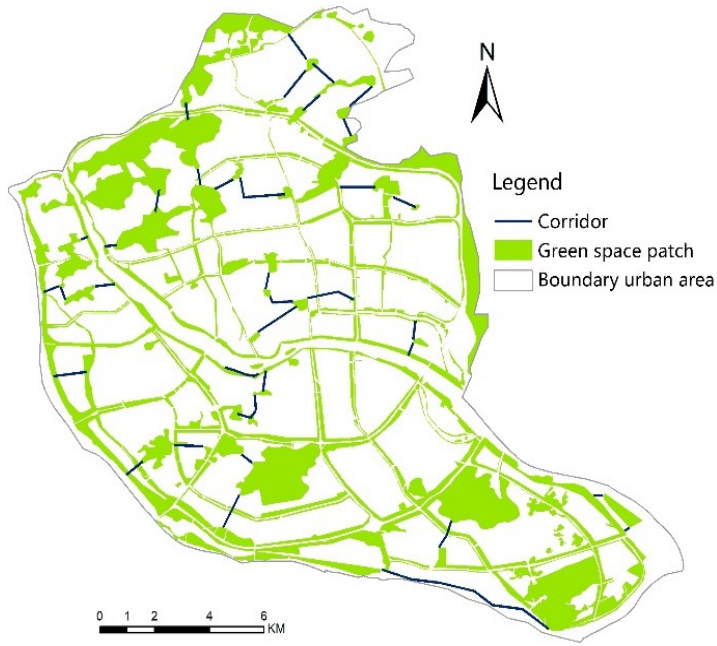
Figure 12. Network planning of ecological green space in Fuzhou City. Table 9. Landscape metrics in different plans of Gu Lou and Tai Jing district.